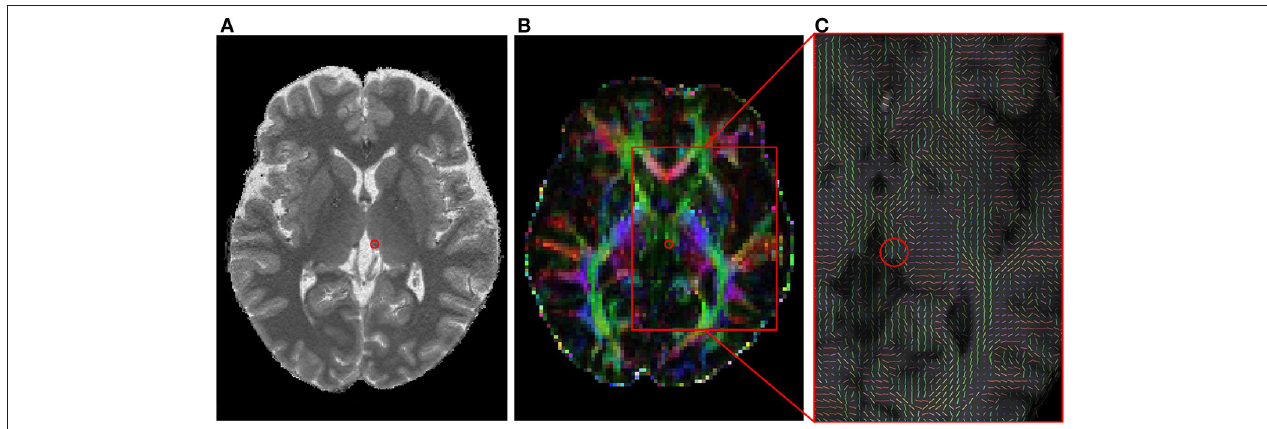
FIGURE 1 | The habenula in a 3T MRI image and its diffusion tensor image. (A) A selected T1 image indicating a habenula area with a red circle. (B) A fractional anisotropy image corresponding to (A) . (C) A zoomed fiber orientation image estimated with BEDPOSTX. The mean principle diffusion direction distribution in the red box of (B) was shown in a vector form. MRI, magnetic resonance imaging.